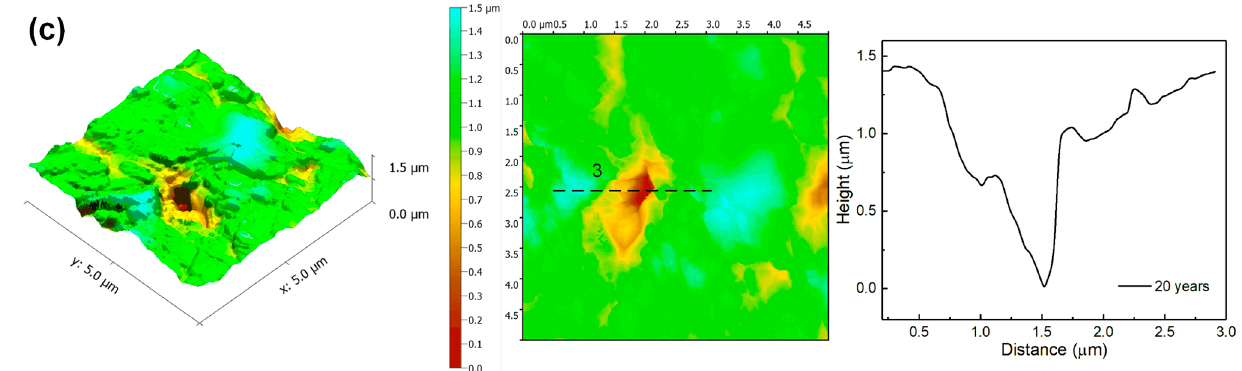
Figure 12. 3D AFM morphologies, 2D AFM morphologies and height profiles of epoxy primer-coated aluminum alloys exposed for different numbers of years: ( a ) 7 years; ( b ) 12 years; ( c ) 20 years.